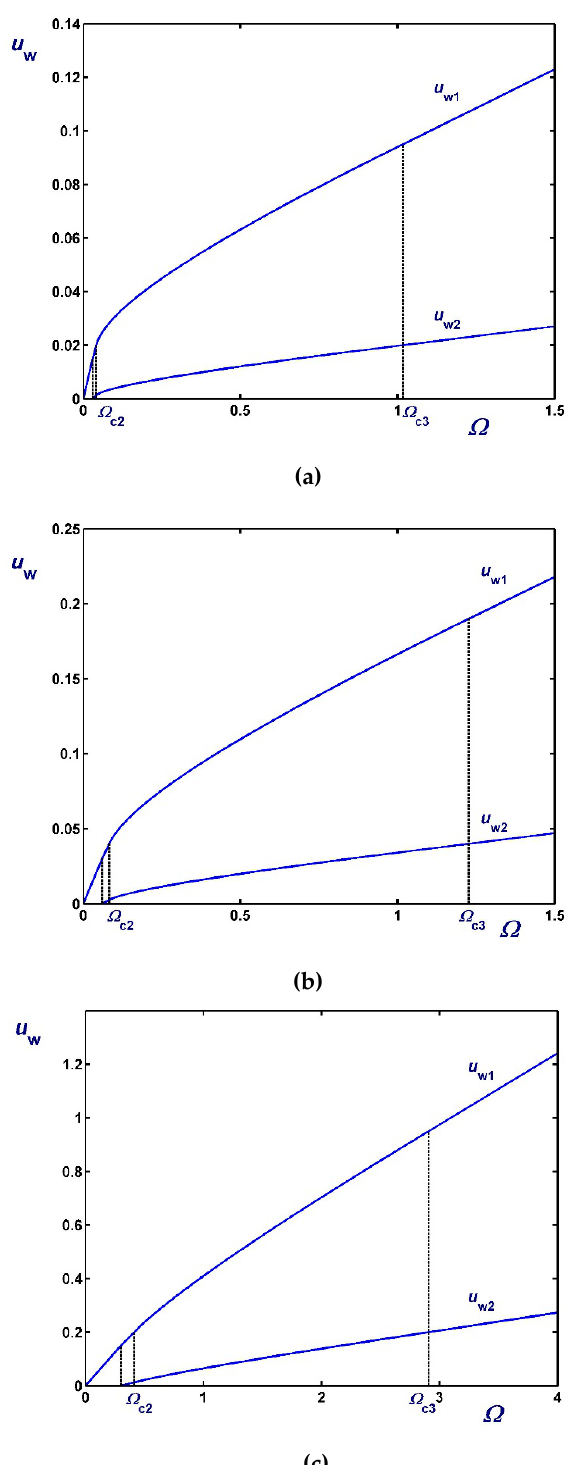
κ= τ = Figure 15. Slip velocities for κ = 0.5, τ c = 0.2 and di ff erent slip numbers: ( a ) B = 0.05 (weak slip); ( b ) Figure 15. Slip velocities for 0.5 , 0.2 c and different slip numbers: ( a ) 0.05 B B = 0.1 (moderate slip); ( c ) B = 0.5 (strong = = (moderate slip); ( c ) 0.5 B (strong slip). (weak slip); ( b ) 0.1 B